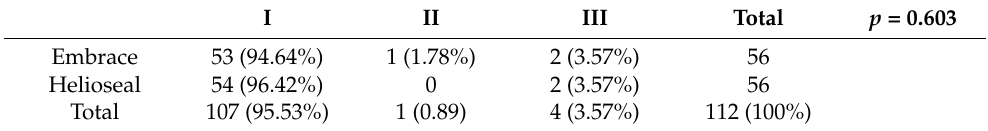
Table 1. Assessment of sealant retention rate after 6 months according to Simonsen’s criteria.